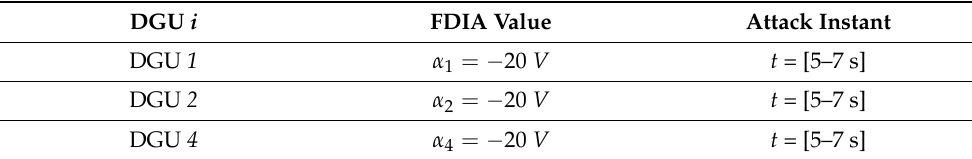
Table 5. Simultaneous voltage FDIA parameters.